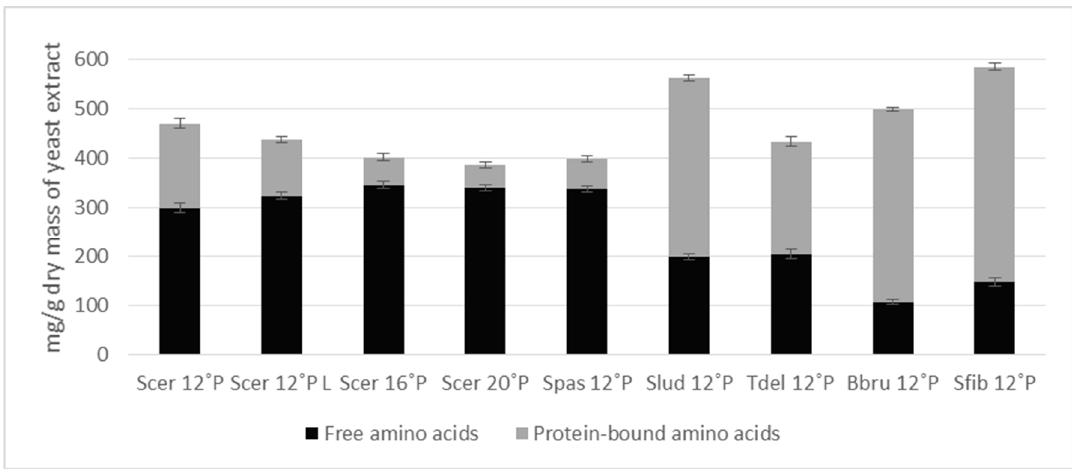
Figure 2 . Free and protein-bound amino acids in yeast extracts made from spent yeast of beer production via autolysis; influence of original gravity (12 ˚ P, 16 ˚ P, 20 ˚ P), time of yeast cropping (after primary fermentation vs. after cold beer lagering (L)) and yeast strain (Scer, Spas, Slud, Tdel, Bbru, Sfib); for results of ANOVA and pairwise t test, see text; data are expressed as mean values ± confidence limits .